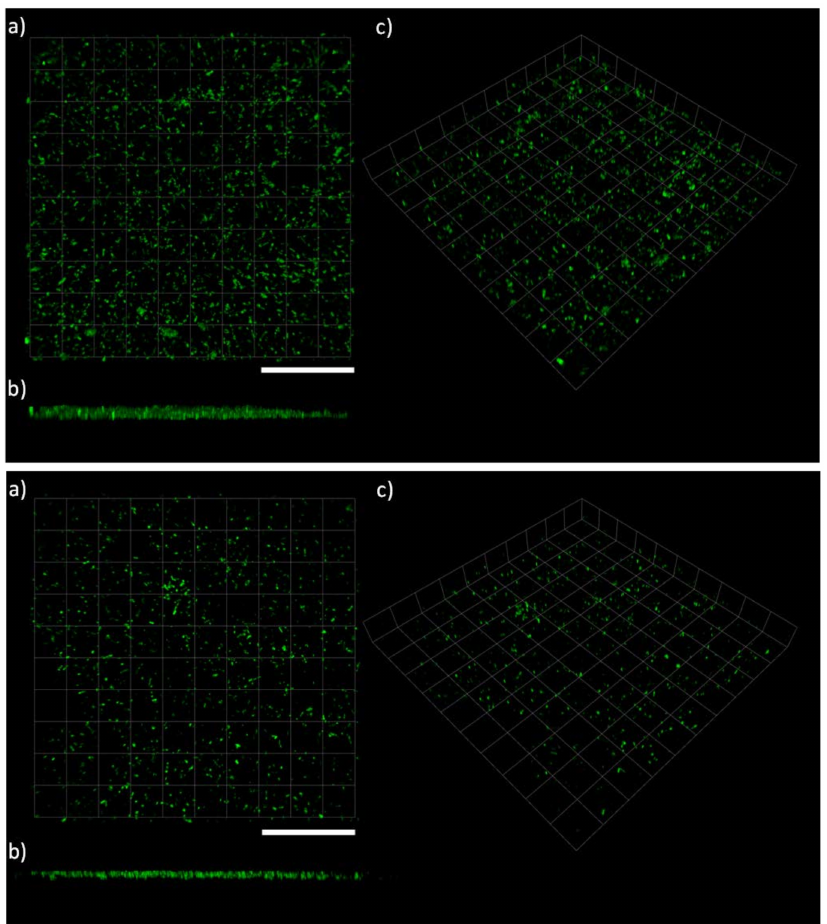
Figure 5. CLSM microscopy on LIVE/DEAD stained C. marina on the coated surfaces at the end-point (48 h), where ( Top ): Cu 2 O + PMMA + ROS, ( Bottom ): Cu 2 O + PMMA and ( a ) top view, ( b ) side view and ( c ) 3D view. Scale bars= 112 µ m. PMMA = poly(methyl methacrylate), ROS = rosin. Table 2. Biovolume and maximum biofilm thickness of C. marina found on coated surfaces